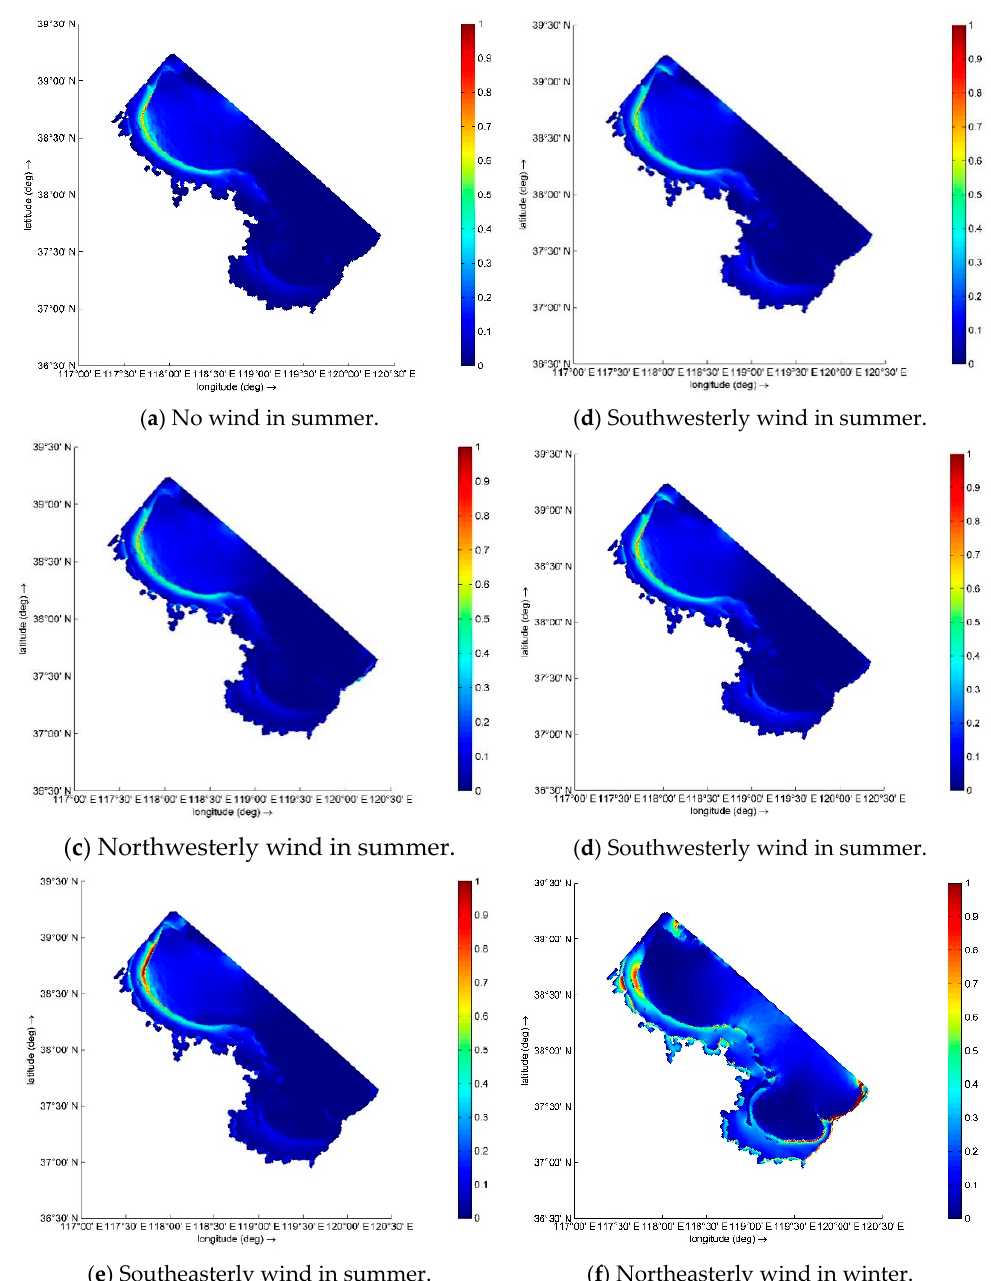
Figure 13. The shear stress on the bottom bed of the Yellow River delta under no wind ( a ), northeasterly wind ( b ), northwesterly wind ( c ), southwesterly wind ( d ), and southeasterly wind ( e ) in summer and northwesterly wind ( f ) in winter (unit: Pa).